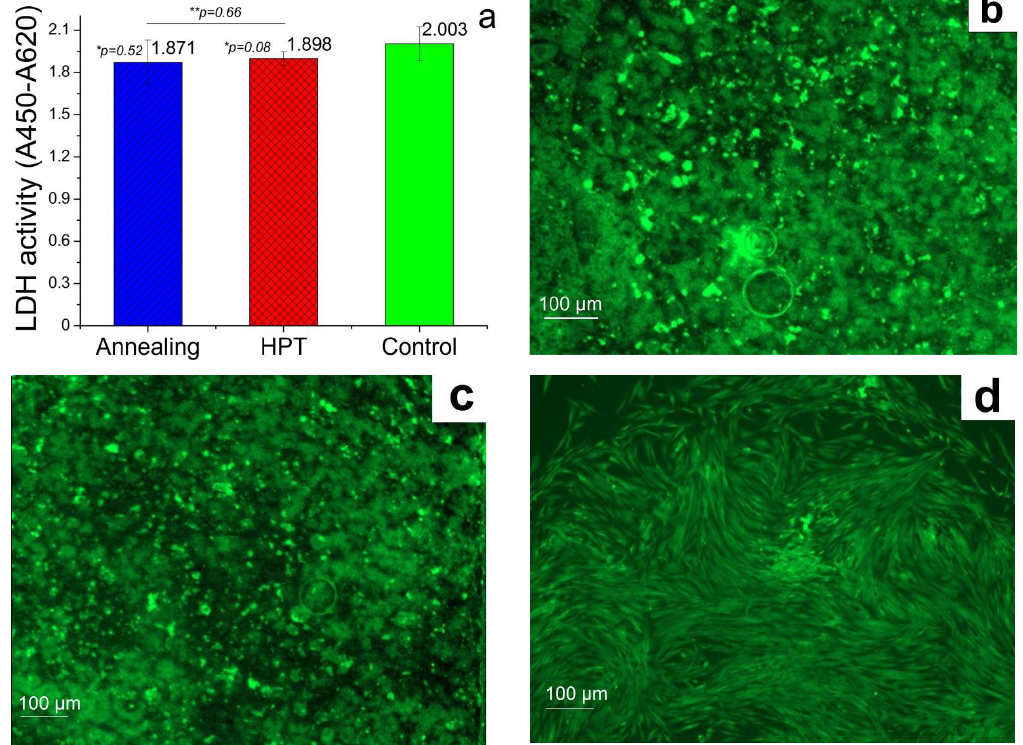
Figure 7. Multipotent mesenchymal stromal cell lactate dehydrogenase activity ( a ) and colonization of the surface of samples the annealed ( b ) and HPT-treated ( c ) alloy in comparison with cellular control ( d ). Live MMSC with an intact membrane stain green after treatment by Calcein AM.